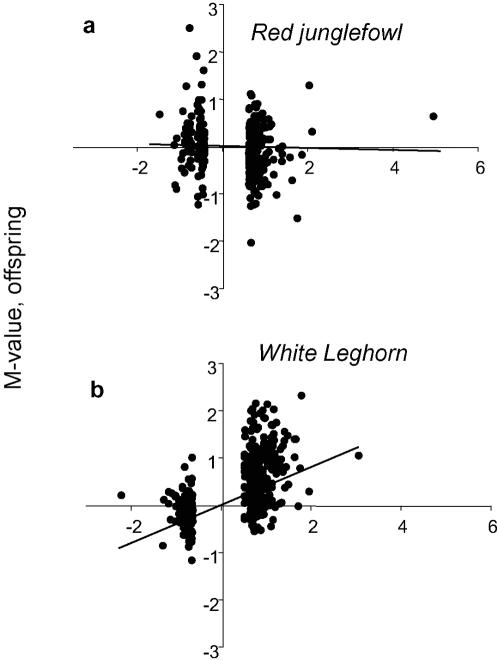
Correlations between magnitude of differential expression of genes between parents and offspring. Diagrams show M-values for the differential expression (comparing stressed vs control parents, and offspring of stressed vs offspring of control parents) of the 500 most differentially expressed genes (largest log2 difference caused by stress in parents) in (a) red junglefowl, and (b) White Leghorns. Each point represents one spot on the microarray. Positive M-values indicate upregulation and negative downregulation by stress (or by having stressed parents). The average correlation line is shown in both comparisons.